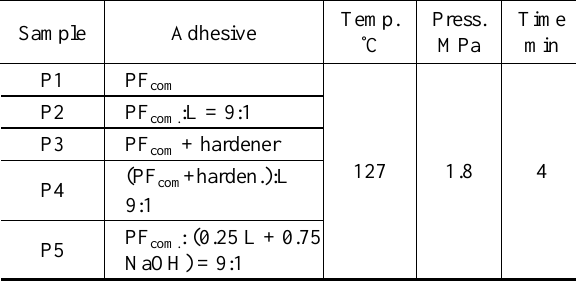
Table 3. Adhesives and bonding regime of plywood samples Sample Adhesive